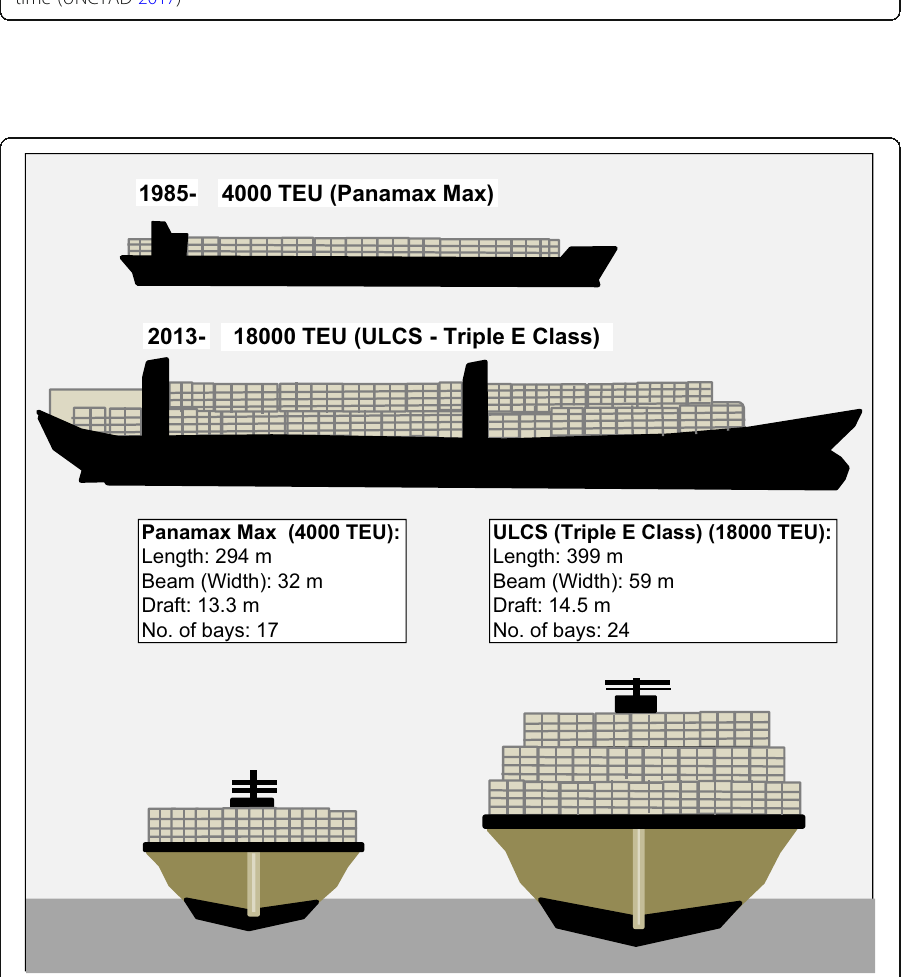
Fig. 7 Overview of the scale of container ships used along the given line shipping trunk line/route (AECOM 2012; Rodrigue et al. 2017; PR